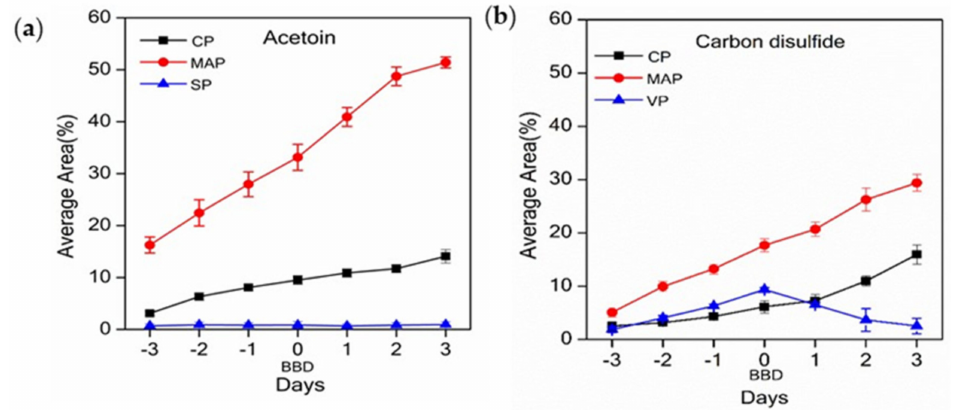
Figure 2. The average area, expressed as a percentage of all analytes, of ( a ) acetoin and ( b ) carbon disulphide (CS 2 ); cling-wrapped packaging (CP), modified atmospheric packaging (MAP), and vacuum packaging (VP); n = 3 ±